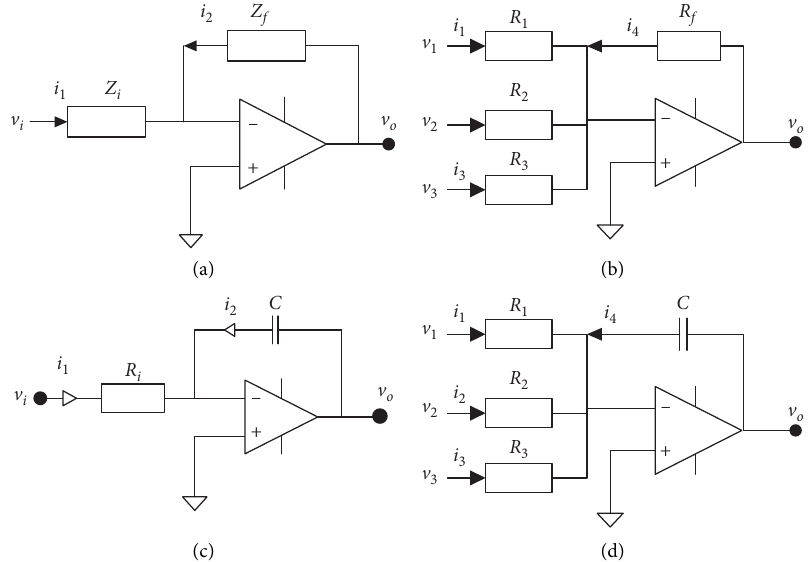
Figure 1: Computing elements. (a) High gain dc amplifier with feedback and input impedances, (b) summing amplifier, (c) integrating amplifier, and (d) summing integrating